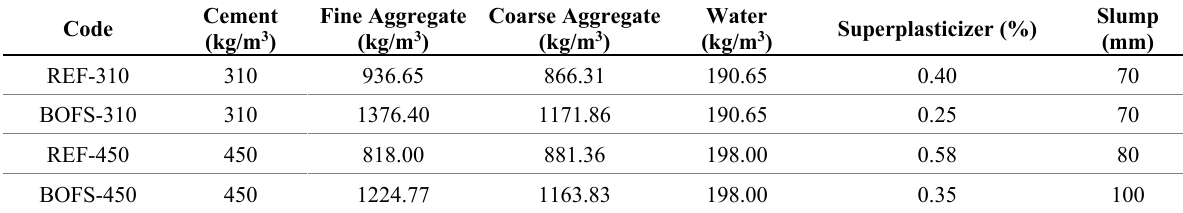
Table 3. Mix Design of the steel slag and reference concretes